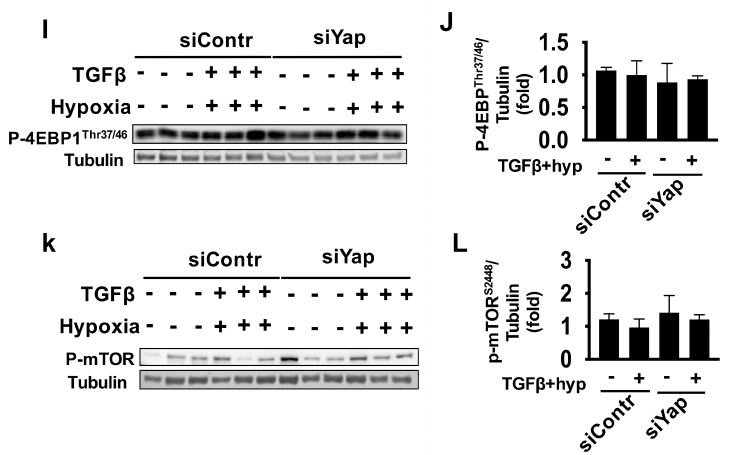
Figure 5. mTOR signaling is decreased under profibrotic conditions through a Yap-independent pathway. ( A , C , E , G , I , K ) Representative immunoblot for indicated proteins of human adult cardiac fibroblasts transfected with siYap or siContr and exposed to hypoxia/TGF β . ( B , D , F , H , J , L ) Fold change immunoblot densitometry analyses of indicated proteins phosphorylated to total ratio or normalized to corresponding loading control. Data represent mean ± S.E.M of fold changes to siContr-infected vehicle-treated control group ( − ); n = 3–4/condition, * p < 0.05 vs. corresponding ( − ) control.